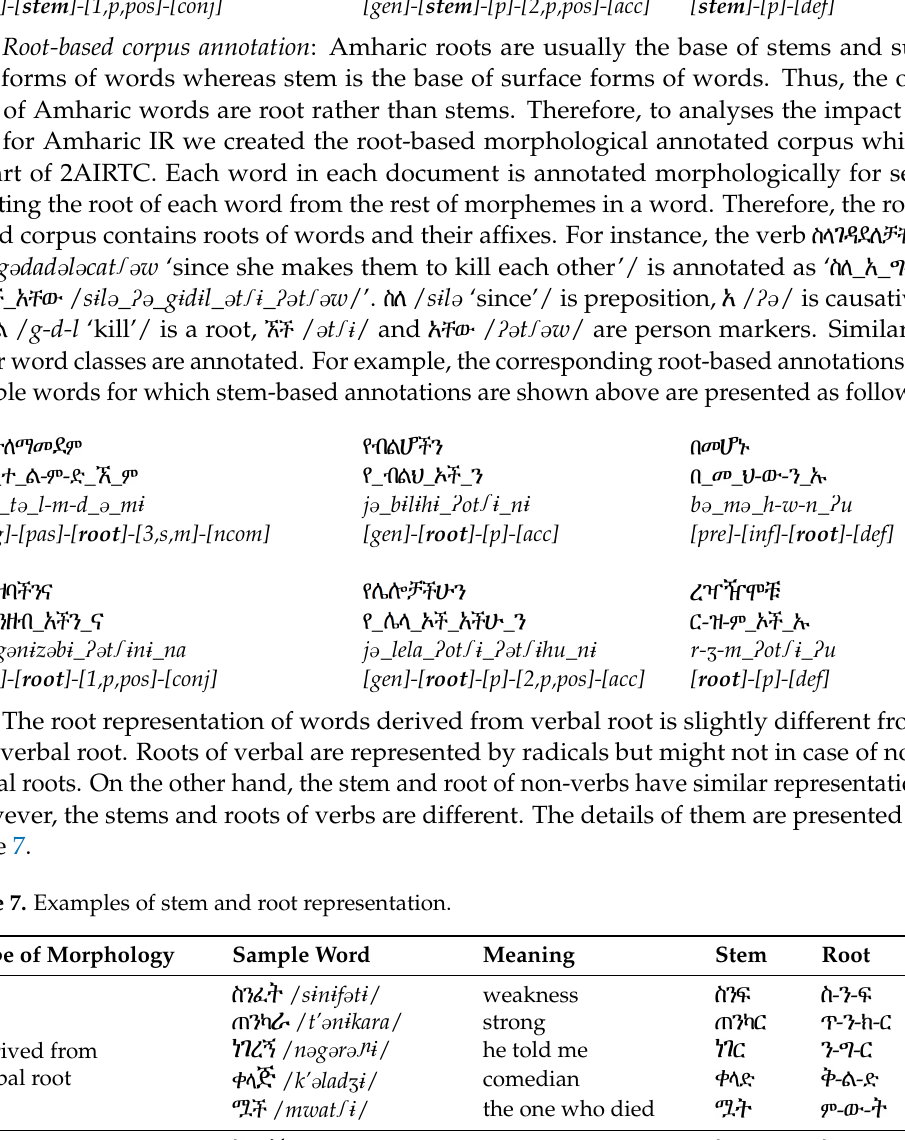
Table 2. Templates of tri-radical verbs types. Verb